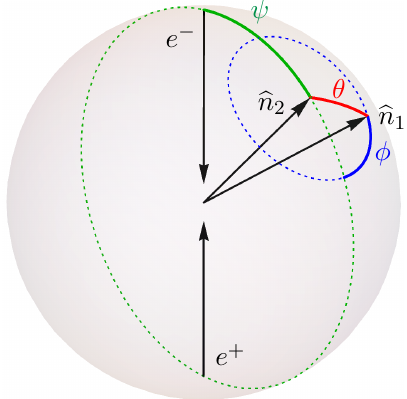
Figure 3 . Kinematics of a two-point energy correlator in the process e + e − → hadrons . The picture shows the spatial geometry in the center of mass frame; time is suppressed. Particles e + and e − propagate in along the ± ~e z directions, and we measure energy flux in the directions n 1 , n 2 . (The b b correlator is invariant under swapping e + and e − .) ψ (solid green arc) is the angle between one of the detectors n 2 and the beam direction, θ (solid red arc) is the angle between detectors, and φ b (solid blue arc) parametrizes the angle of n 1 around n 2 on the celestial b b